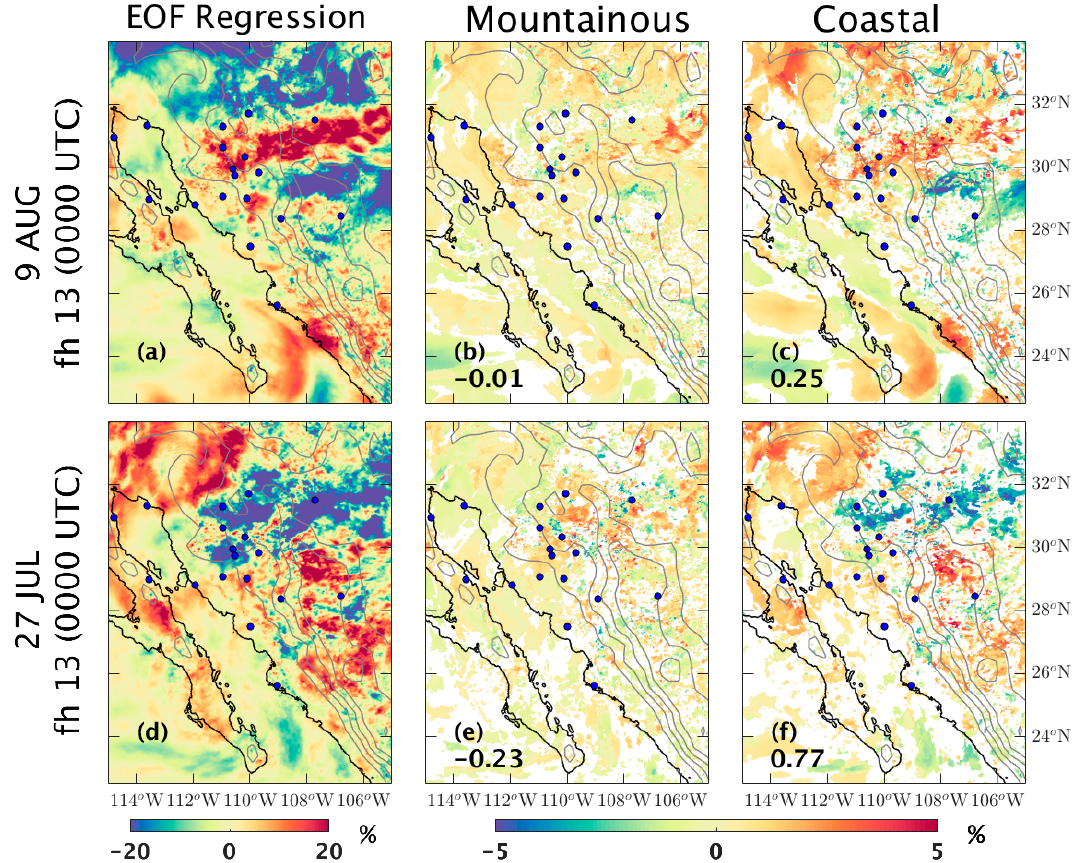
Figure 10. This figure displays the mean hourly sensitivity of WRF-GFS PWV across the domain, relative to the WRF-GFS-equivalent initial PWV in the mountain sites ( b , e ) and coastal sites ( c , f ) at forecast hour (fh) 13 for the 9 August ( b , c ) and 27 July ( e , f ) cases. Only statistically significant correlations (p < 0.05) are displayed. Regression maps of the EOF analysis are displayed for the fh 13 ( a , d ). Pattern correlation value between the mean hourly sensitivity and its respective EOF regression map is displayed on the lower left of the panels ( b , c , e , f ). Note that the PWV in the domain is more sensitive to the change in initial PWV in the coastal sites than that in the mountainous site. The pattern of the coastal areas resembles the regression map for each case, as shown by the pattern correlation values.